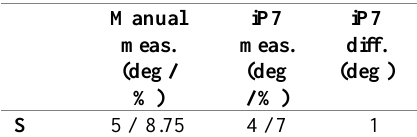
Table 10. Slope of ramp using a 3D point cloud generated using a full set of images from pre-calibrated iP7